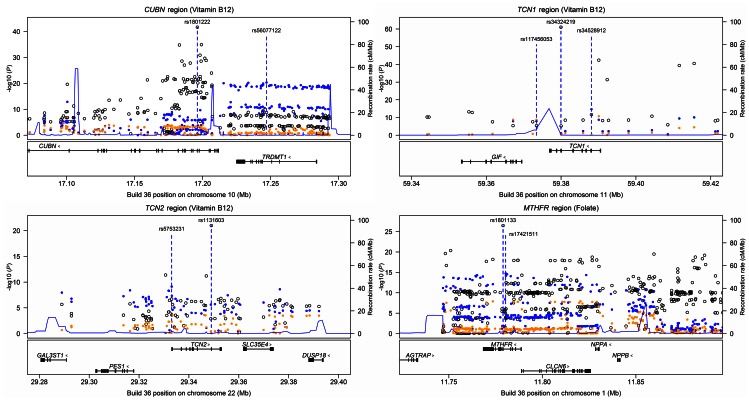
Regional plots illustrating conditional analyses of loci with more than one independent association signal for serum B12 (CUBN, TCN1 and TCN2) or serum folate (MTHFR).Genotyped and imputed SNVs passing quality control measures in the Icelandic data are plotted with their P-values (as −log10 values) as a function of genomic position (NCBI Build 36). Only SNVs with P<10−5 in at least one of the models are shown. The analyses were performed in 25,960 and 20,717 chip-genotyped Icelanders for B12 and folate, respectively. Data points illustrated by open circles represent unconditional analyses (M0); blue dots are results of analyses conditional on the most significant SNV in M0 (M1) and orange dots are results of analyses conditional on most significant SNVs in M0 and M1. Estimated recombination rates (HapMap CEU) are plotted to reflect the local LD structure. Gene annotations were obtained from RefGene.